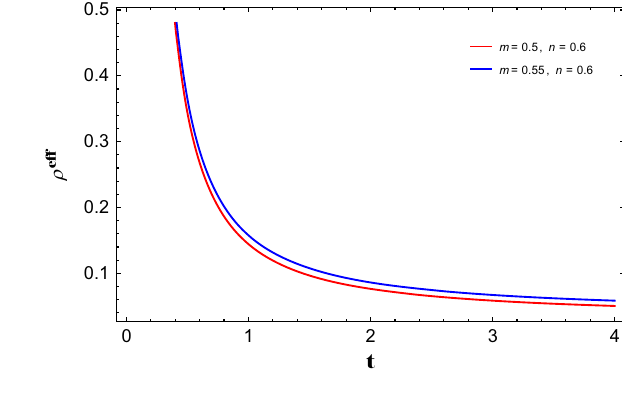
Fig. 6 Evolution of ρ eff in time